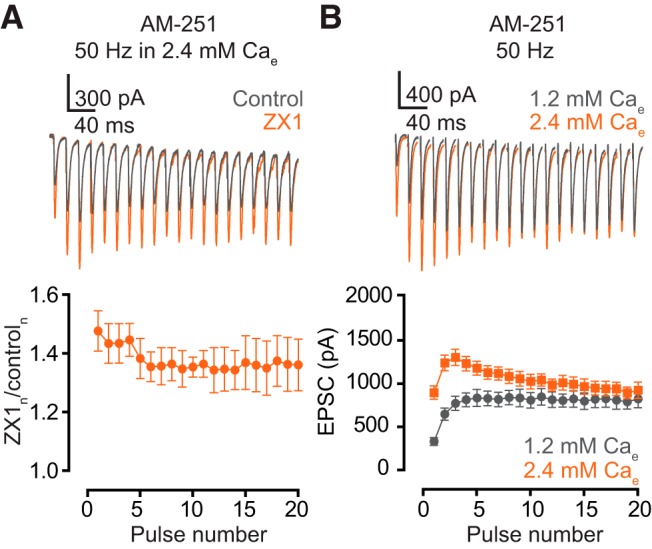
Endocannabinoid signaling is necessary for the zinc-mediated enhancement of EPSCSS. A, Upper panel, representative traces of AMPA EPSCs, evoked by 50-Hz 20-pulse train, in the presence of 1 µm AM-251 before (gray) and after ZX1 (orange). Lower panel, summary graph showing average ratios of AMPA EPSCs in the presence of ZX1 to that in control during the train (ZX1–2/control1–2 vs. ZX16–20/control16–20: 50 Hz: n = 5, p = 0.13). B, Upper panel, representative traces of AMPA EPSCs evoked by 50-Hz 20-pulse train in 1.2 mm (gray) and 2.4 mm (orange) external calcium in the presence of AM-251. Lower panel, summary graph showing average AMPA EPSC amplitudes during the train in 1.2 mm (gray) and 2.4 mm (orange) external calcium in the presence of AM-251. (EPSC16–20 amplitude in AM-251: 1.2 vs. 2.4 mm calcium, n = 5, p = 0. 09). Values represent mean ± SEM. Detailed values and statistical tests: A, lower panel: ZX1–2/control1–2 vs. ZX16–20/control16–20: 50 Hz: control: 1.47 ± 0.06 vs. ZX1: 1.36 ± 0.08, n = 5, p = 0.13, t = 1.4, df = 9; paired t-test. B, lower panel: EPSC16–20 amplitude: AM-251: 1.2 mm calcium: 805 pA ± 97 pA vs. 2.4 mm calcium: 921 pA ± 80 pA, n = 5, p = 0.19, F = 1.7, DFn = 1, DFd = 40; two-way ANOVA.